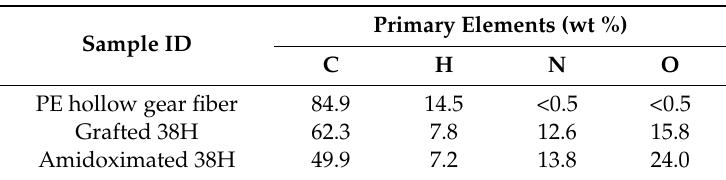
Table 1. Elemental analysis results for the 38H adsorbent material before and after grafting of copolymers and after